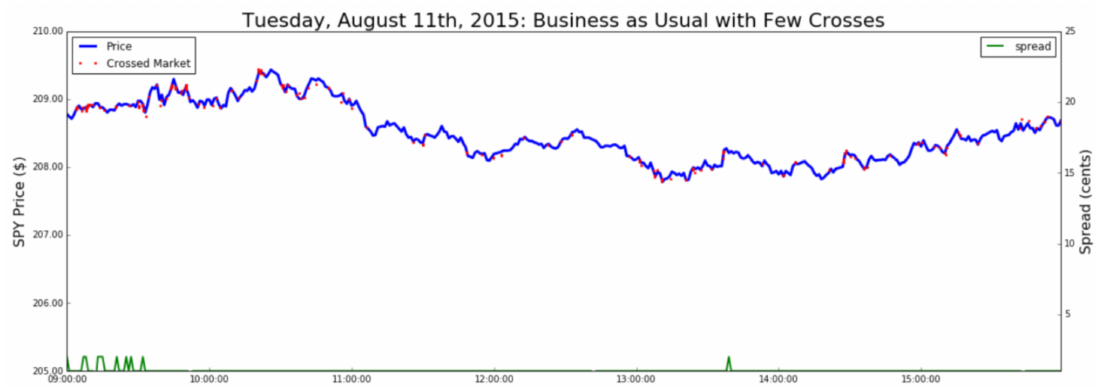
Figure 3. Crosses and Spreads in the SPY on 11 August 2015—“typical market